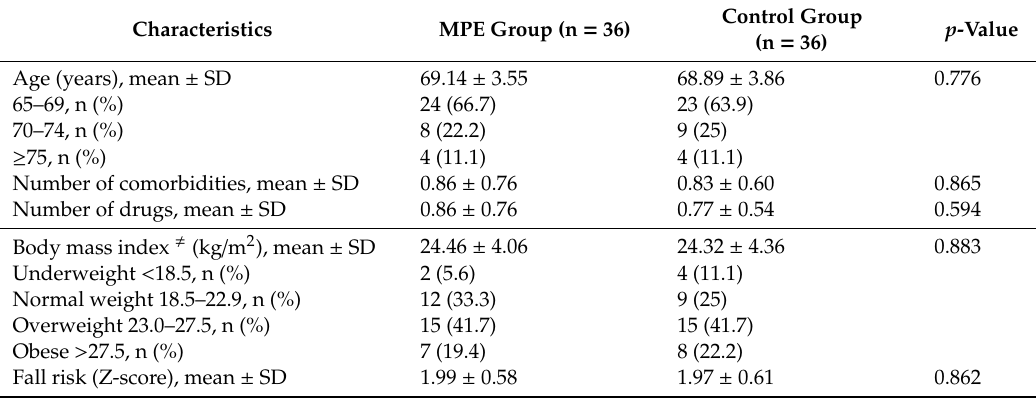
Table 2. Baseline characteristics of participants.